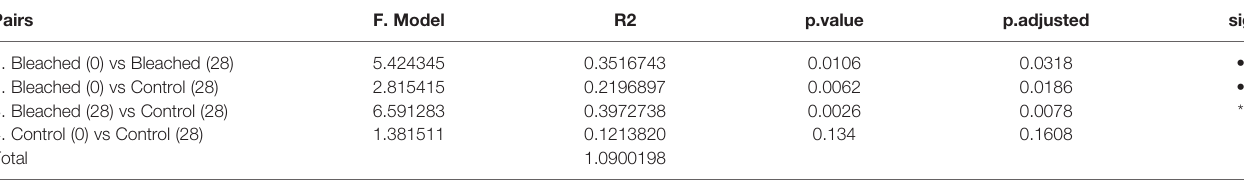
TABLE 1 | Pairwise PERMANOVA analysis of the bacterial community of mucus between Control and Bleached samples. Pairs